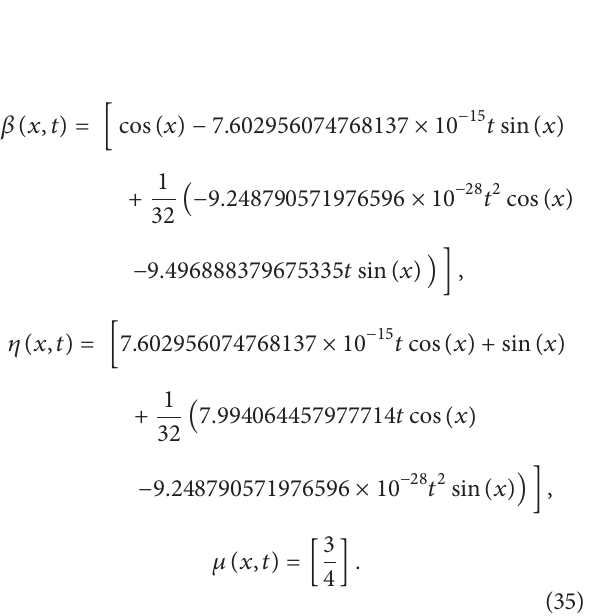
Figure 19: 2D, comparison of ordered solutions for 𝛽(𝑥,𝑡) at 𝑡 = 0.1 .